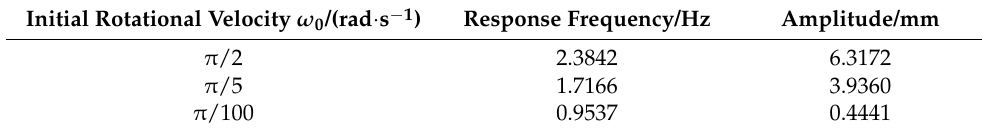
Table 8. Dynamic responses of point A of M1, T = 0.1 s.